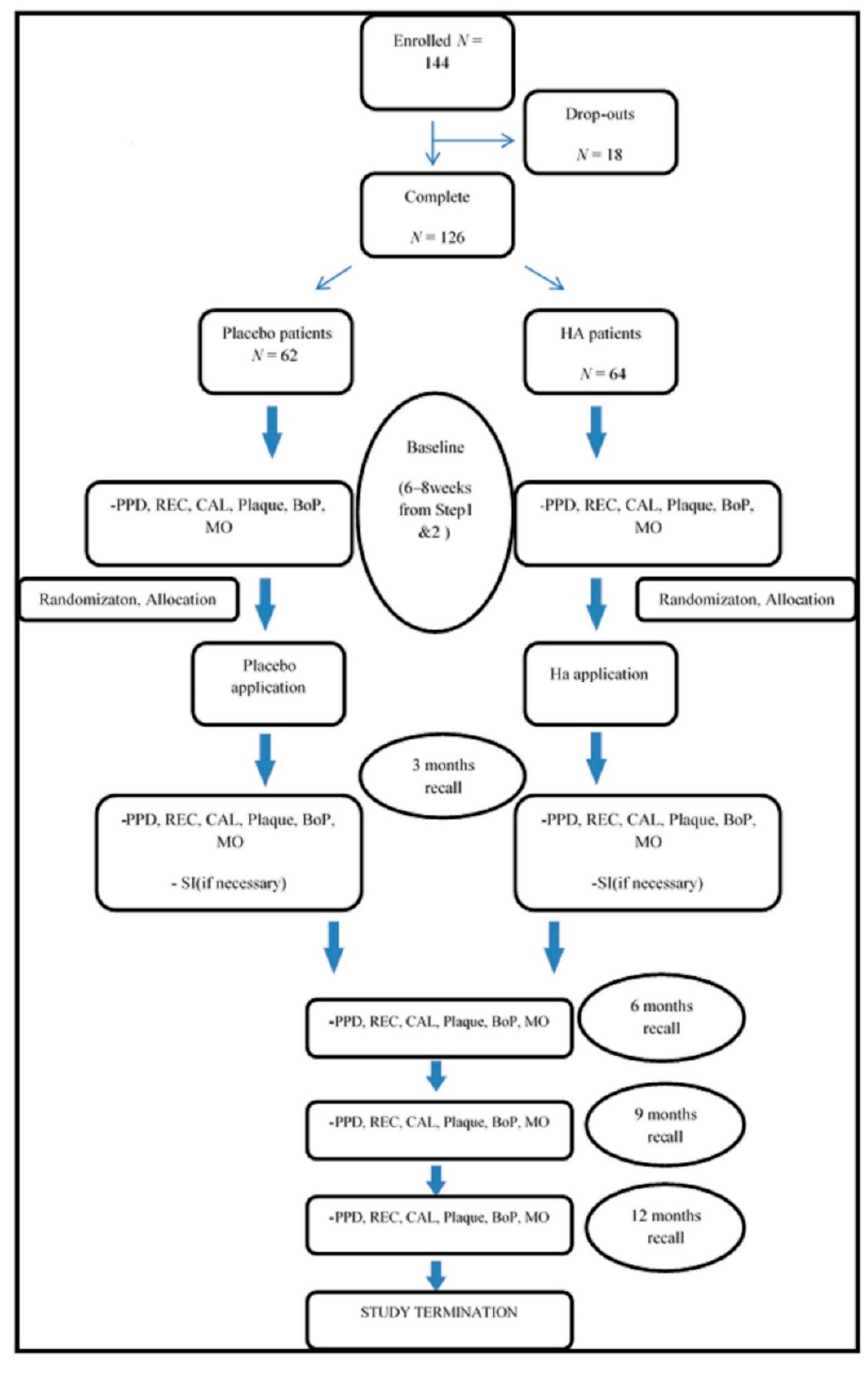
Figure 3. Protocol flow chart.